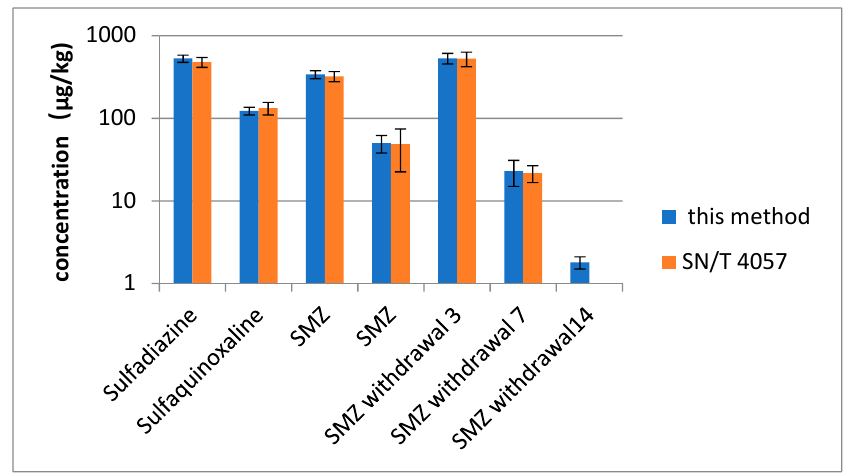
Figure 3. The result of SAs in egg samples with this method and SN/4057. SMZ withdrawal 3, 7, 14 is egg samples from 3, 7, 14 days after drug withdrawal.